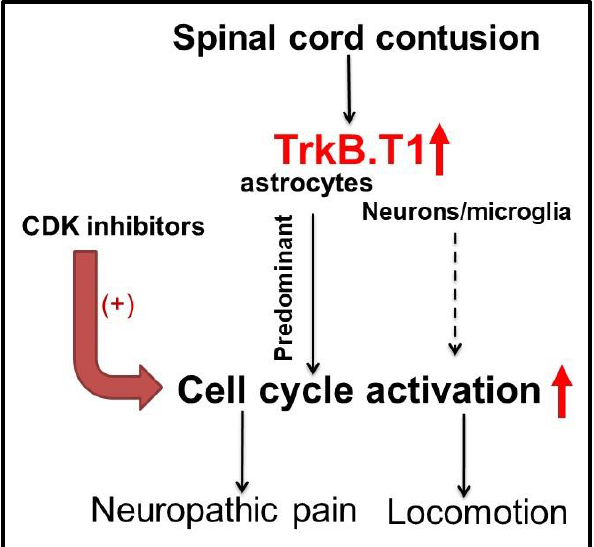
Figure 3. TrkB.T1 contributes to neuropathic pain following spinal cord injury through regulation of cell cycle pathways. Cyclin-dependent kinase (CDK).